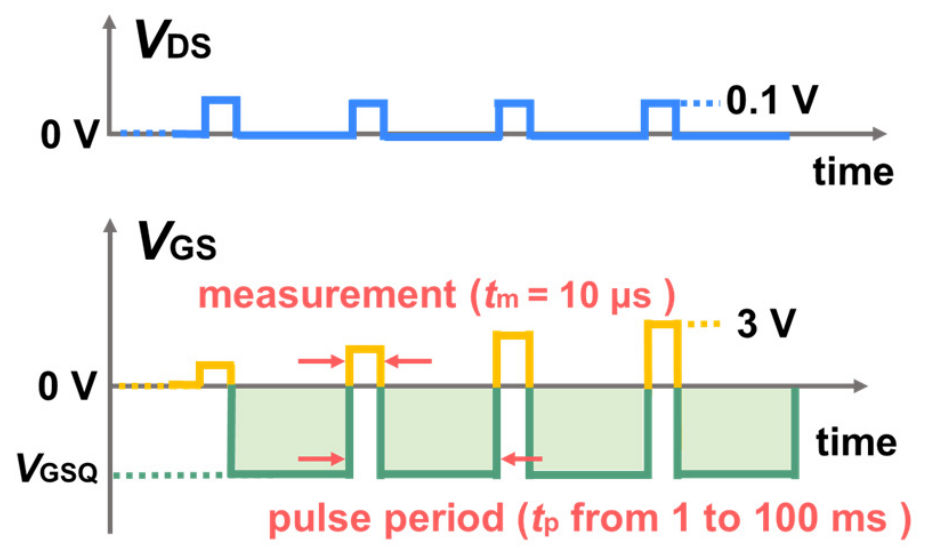
Figure 2. Schematics of a pulsed transfer characteristic test with negative quiescent gate bias (V GSQ ).